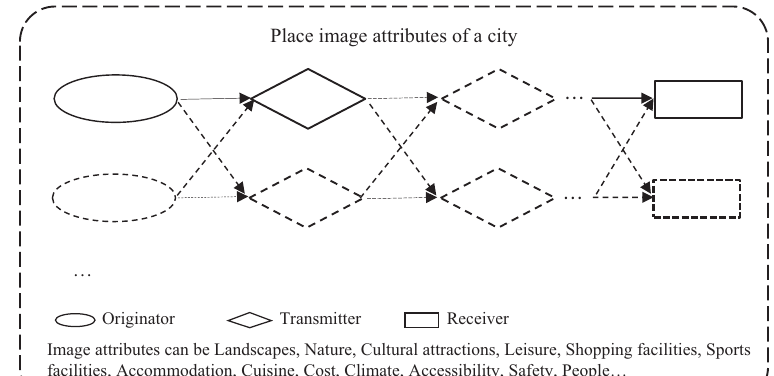
Figure 2. Conceptual